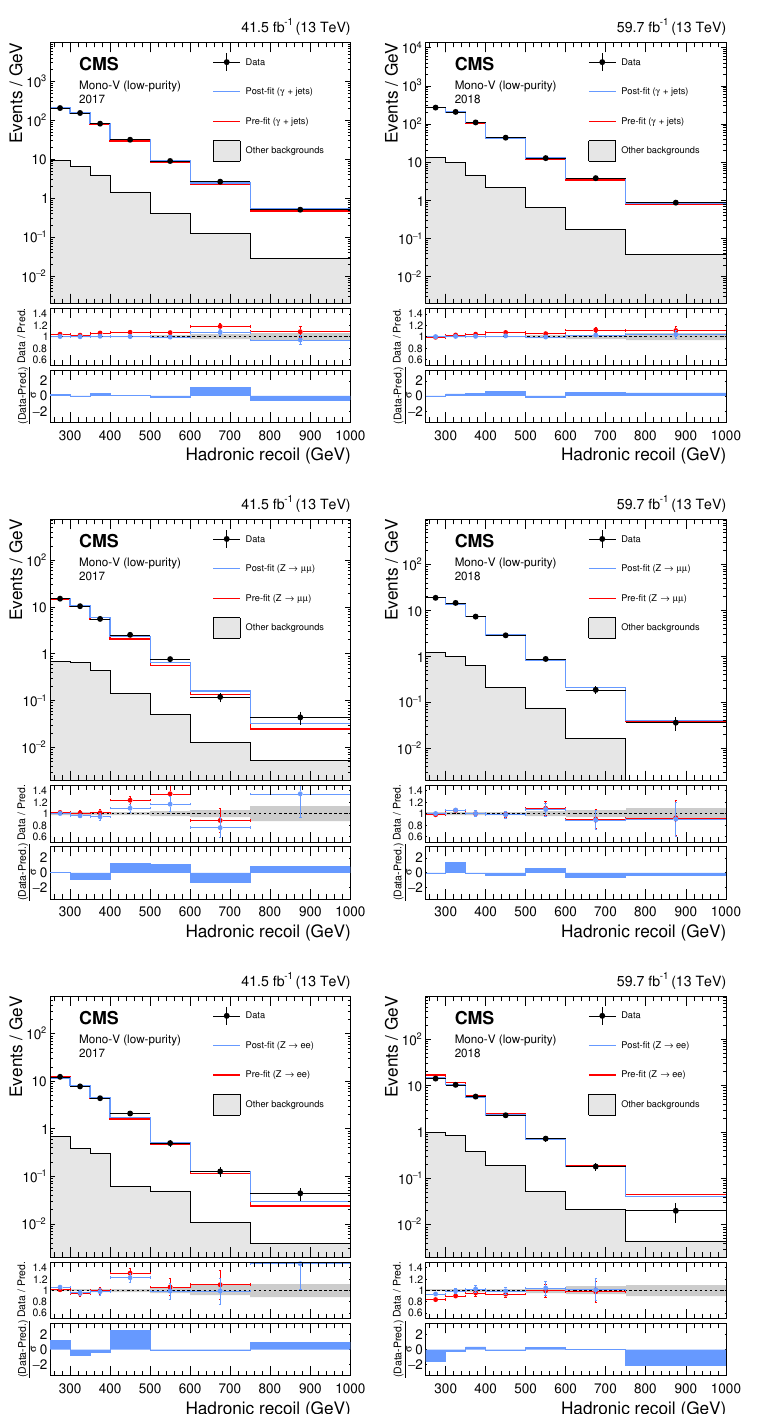
Figure 15 . Hadronic recoil distributions in the photon (upper), dimuon (middle) and dielectron control regions (lower) in the low-purity mono-V category. The “Other backgrounds” include QCD multijet production (photon control region), and top quark, diboson, and W+ jets processes (dimuon and dielectron control